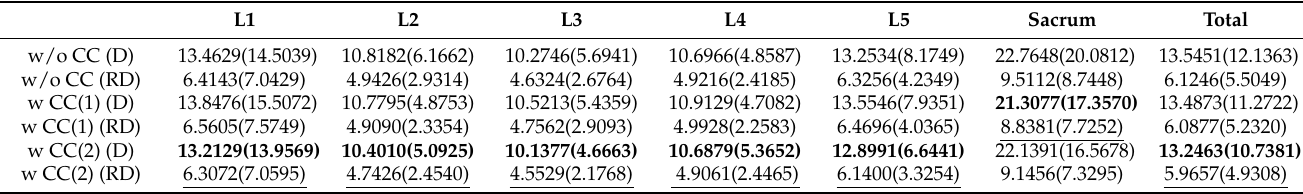
Table 5. Ablation study of CoordConv(CC). CC(1) means using CoordConv in the first encoding layer of M-Net, and CC(2) means using CoordConv in the first two encoding layers, as shown in Figure 8. The lowest value for each column in distance error (D) is marked in bold and underlined in relative distance error (RD).